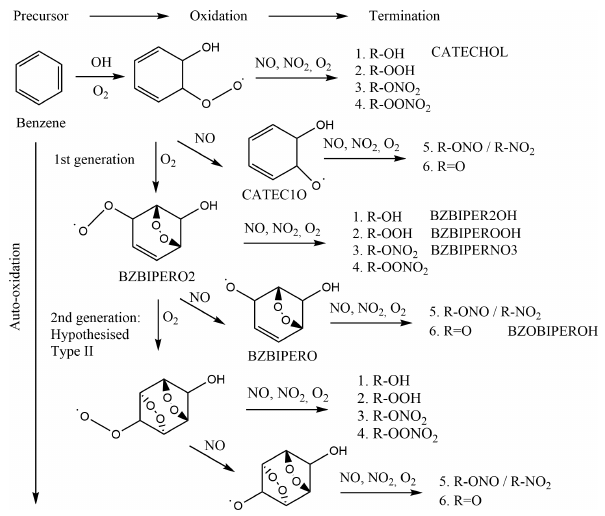
Figure 1. Reaction scheme of benzene oxidation by OH with proposed di-bridged species, adapted from Molteni et al. (2018). Species present in the MCM are